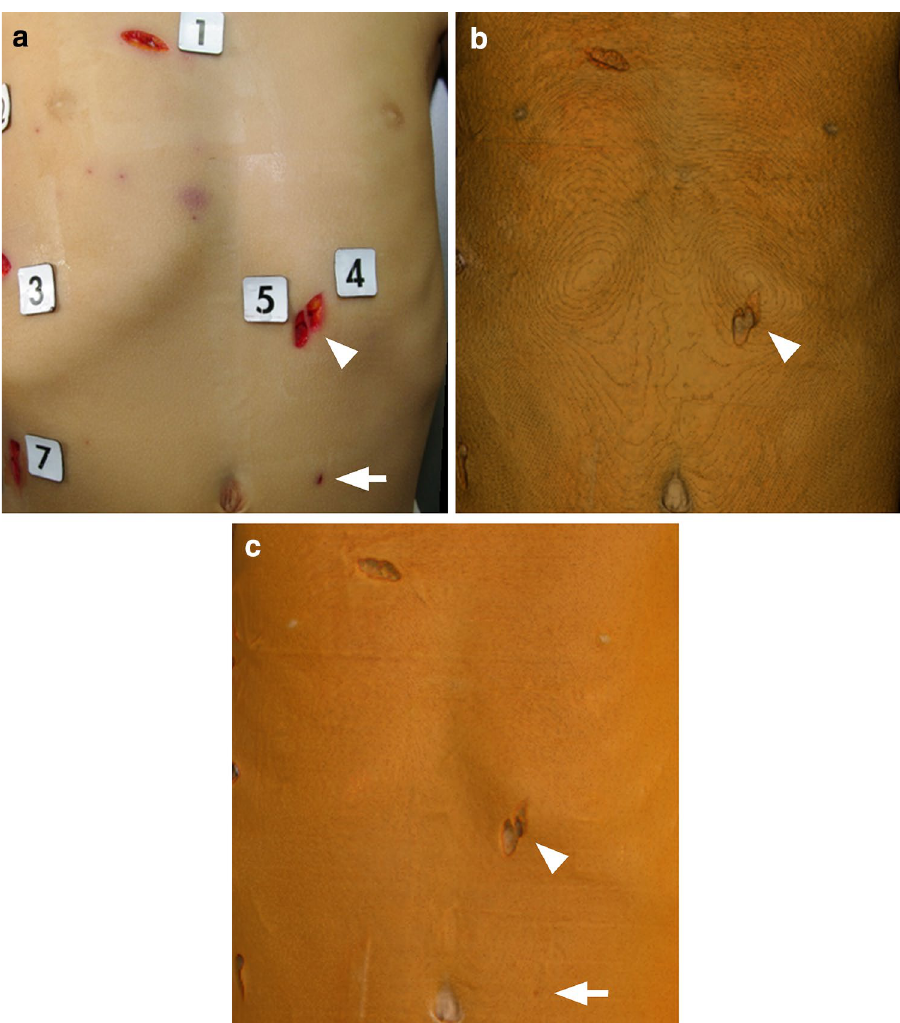
Figure 5. A 5-year-old boy killed by multiple stabs with a knife. (( a ) Photograph, ( b ) 3D CT VR image, ( c ) 3D CT GIR image). The small, shallow stab wound was not detectable on the 3D CT VR image; it was observable on the 3D CT GIR image (arrow). VR failed to distinguish between 2 adjacent stab wounds. On the 3D CT GIR image wound details are observable (arrow